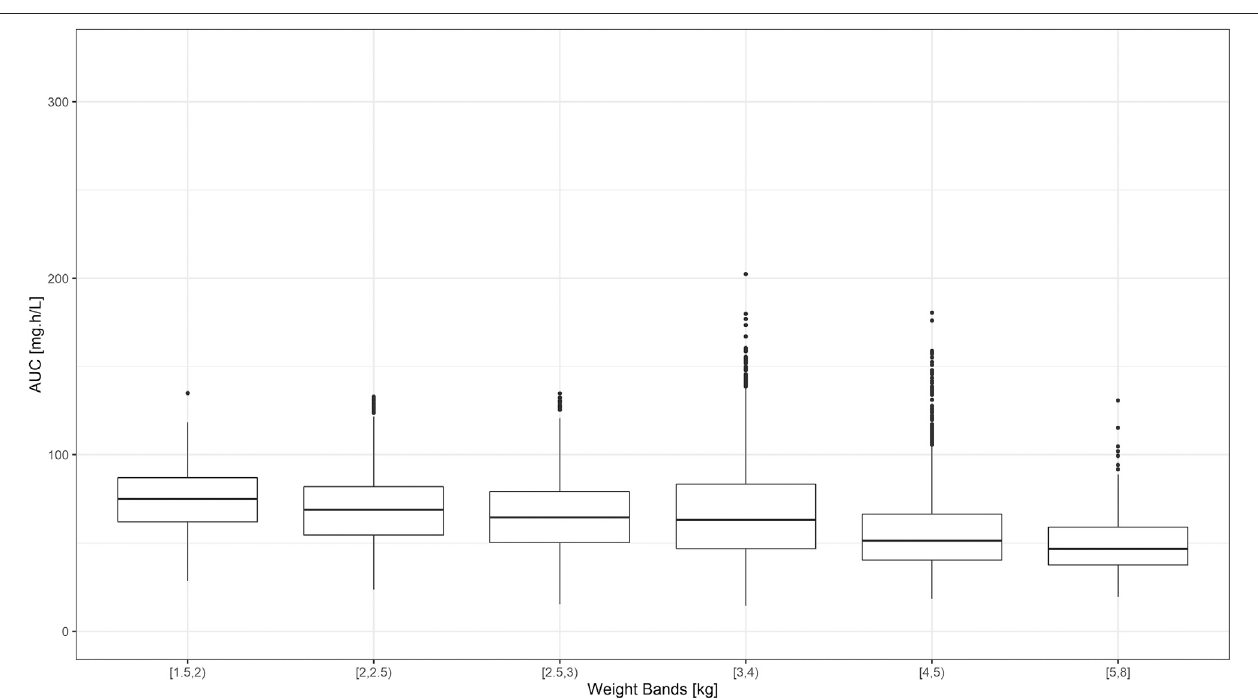
FIGURE 3 | Predicted gentamicin AUC in sepsis patients aged between 0 – 59 days. Estimates are summarized according to the weight bands used in the original AFRINEST/SATTtrials.Hingesrepresent25 th and75 th percentiles(respectively,Q1andQ3),whiskersrepresentQ1 − 1.5IQRandQ3+1.5IQR,respectively,whereIQR is the interquartile range. All the subjects outside this range are represented by the dots ( N (cid:1)